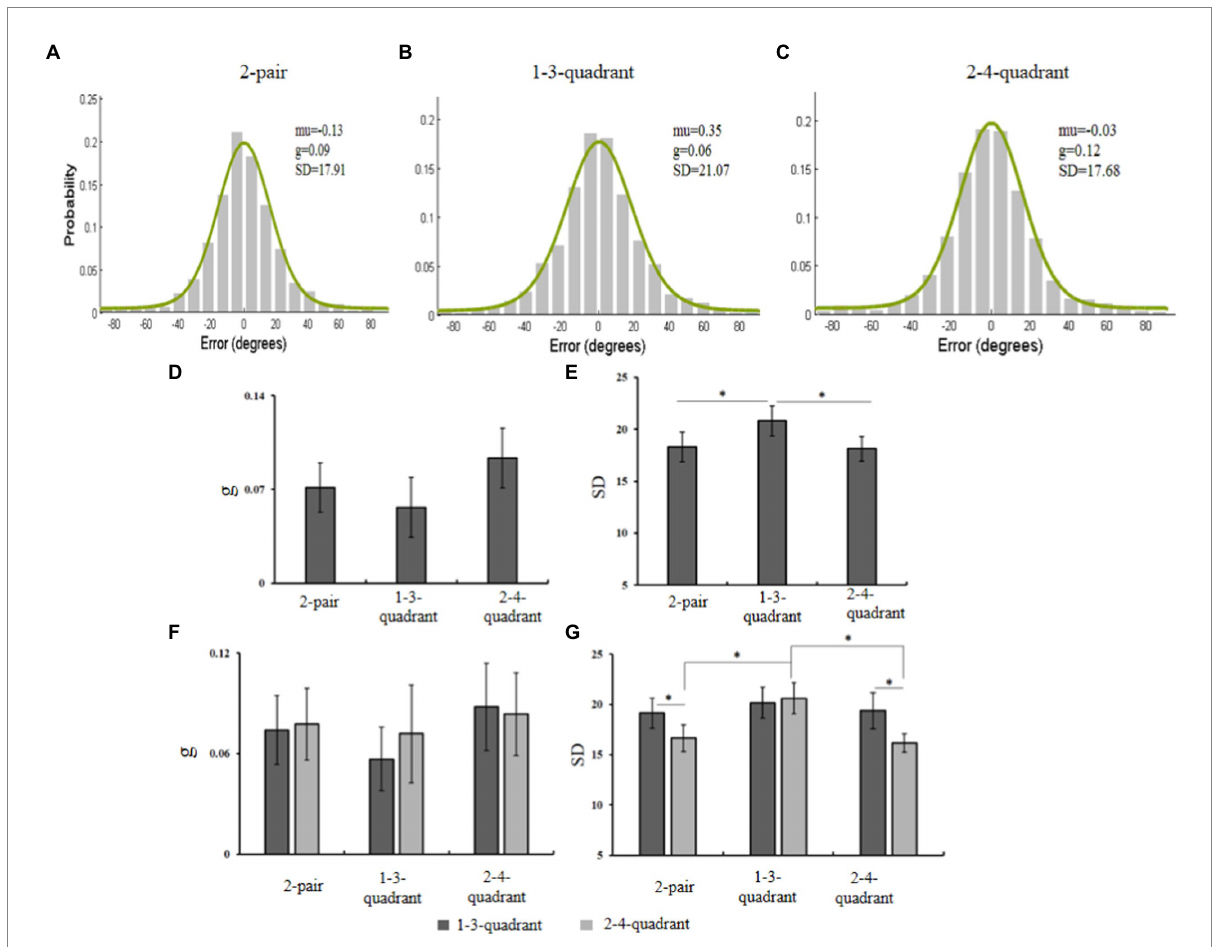
FIGURE 6 (A–C) Distributions of response errors with the fit of standard mixture model in the 2-pair, 1-3-quadrant, and 2-4-quadrant conditions. (D,E) The guess rate and SD in the three conditions. (F,G) The guess rate and SD of items in the 1-3-quadrant and 2-4-quadrant under the three conditions. The black bars represent the standard